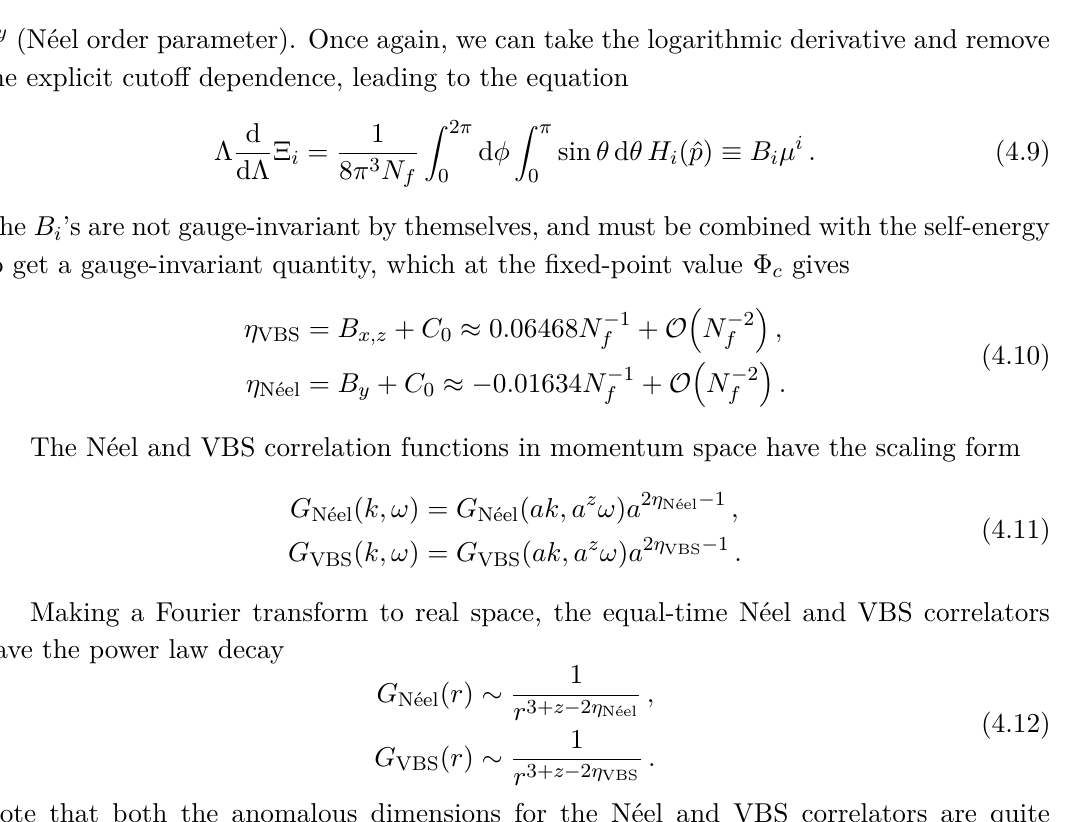
) vertex corrections which contribute to the renormalization of the Néel Figure 5 . The O ( N − 1 f and VBS order parameters. The order parameter receives corrections at one-loop order from the Higgs fields (left) and the gauge boson (center). An additional two-loop O ( N − 1 (right) is possible — the diagram shown involves two intermediate Higgs propagators, but additional diagrams with gauge propagators or mixed gauge/Higgs propagators are possible. These diagrams vanish exactly upon performing the trace over the internal fermion